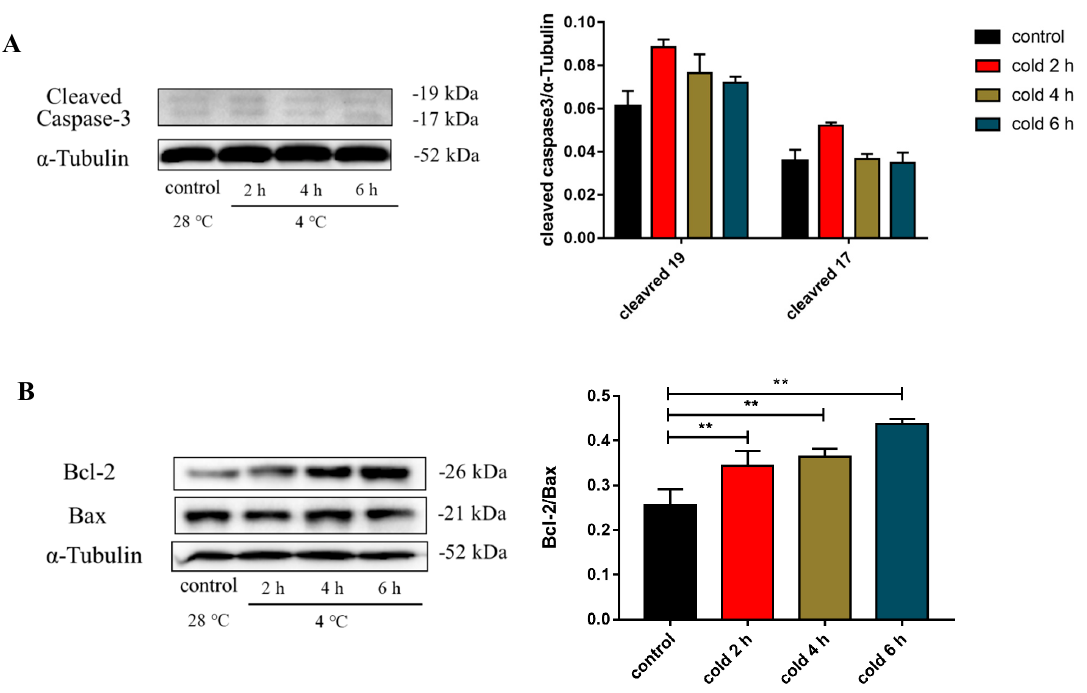
Figure 7. Effect of acute cold exposure on the expression of ( A ) caspase-3, ( B ) Bcl-2, and Bax in the livers of C57BL/6 mice. The data are presented as mean ± SEM ( n = 8). Statistically significant differences are indicated; * p < 0.05 and ** p < 0.01.